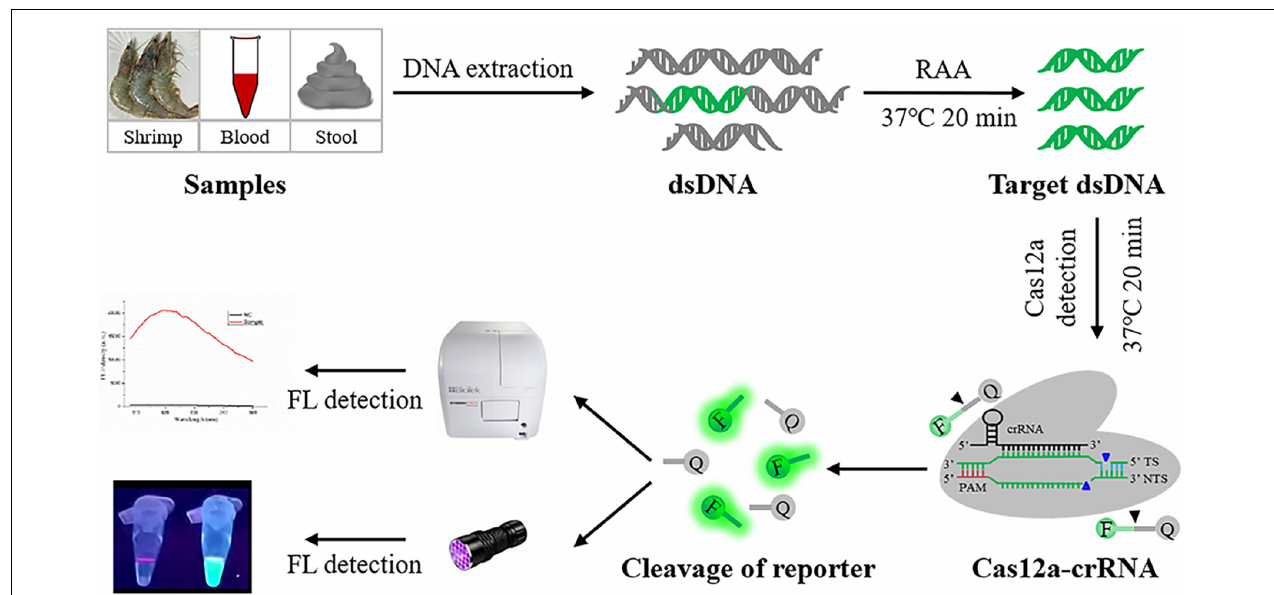
FIGURE 1 | Schematic diagram of RAA-CRISPR/Cas12a assay in the detection of V. vulnificus . FL,